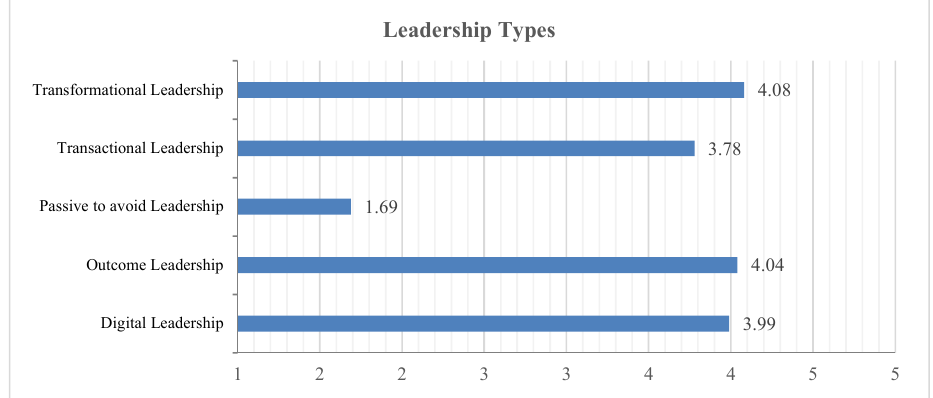
Figure 5. Leadership